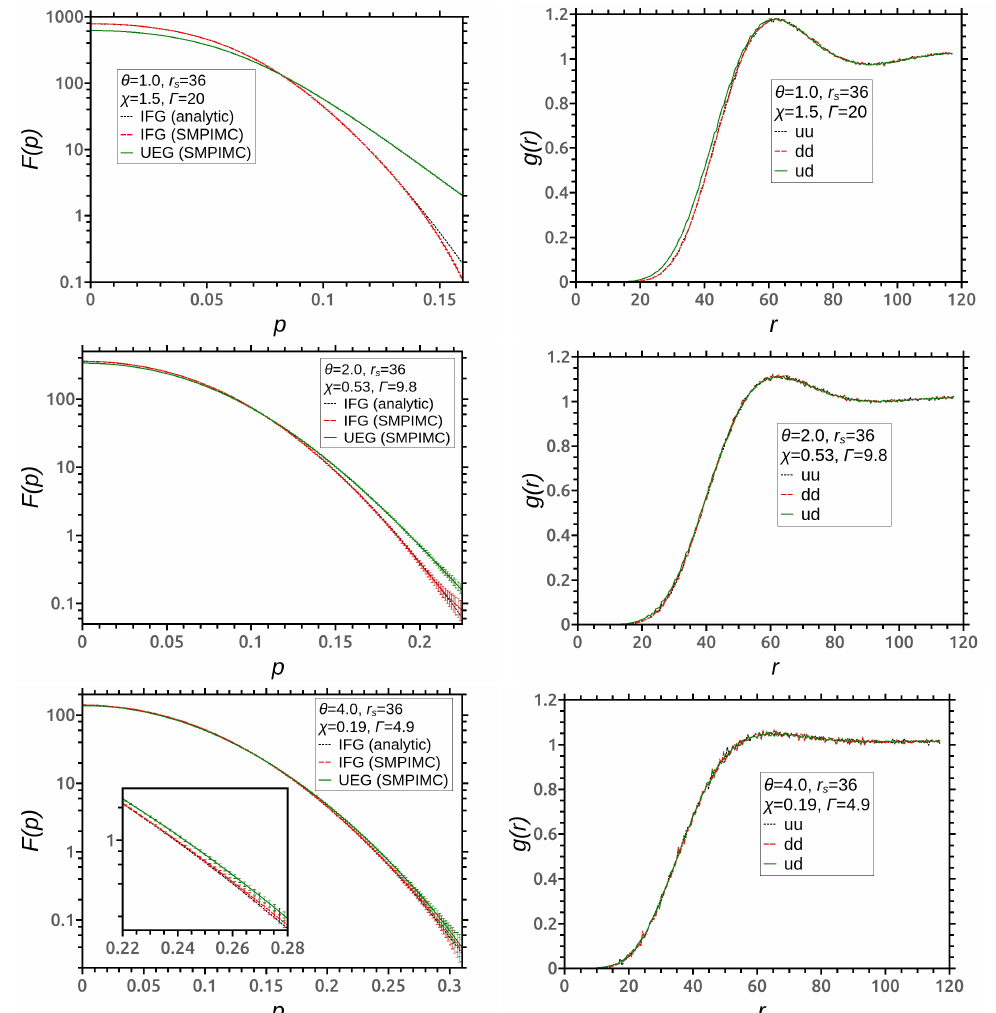
Figure 5. Left plots: single-particle MDFs of the unpolarized UEG at r s = 36 and θ = 0.5,1,4 calculated with the SMPIMC method. The results are compared with the SMPIMC for the IFG at the same conditions and with the analytical Fermi distributions. Right plots: PCFs g uu , g dd , and g ud of the